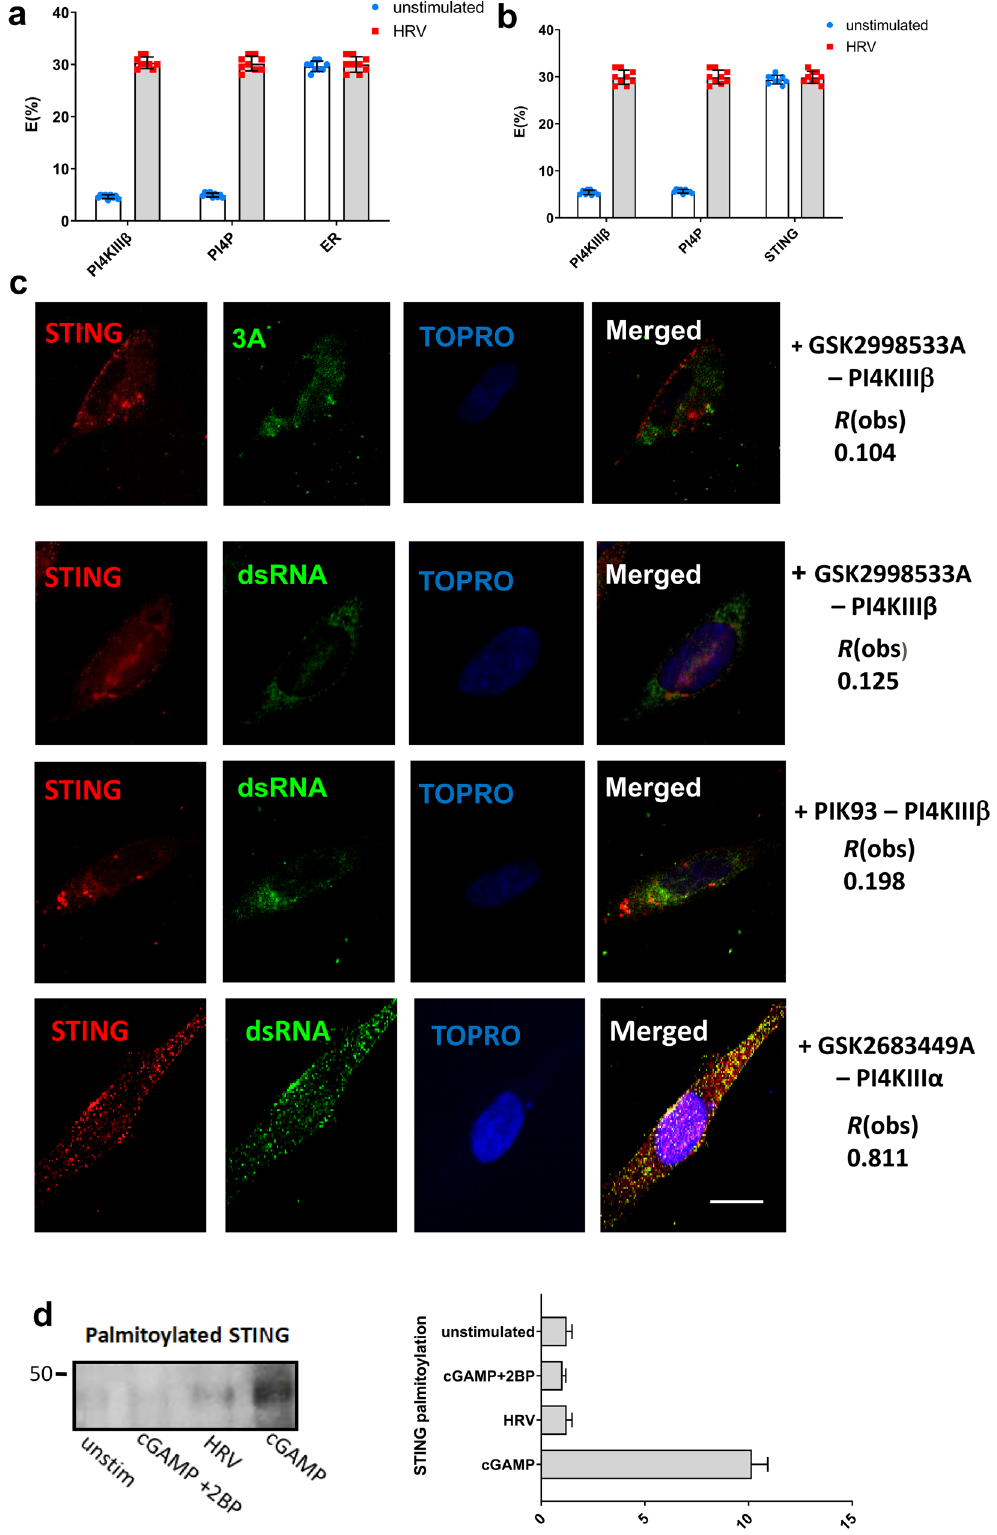
Fig. 4 STING interactions with PI4KIII β , PI4P and ER. Fluorescence resonance energy transfer (FRET) studies to determine STING interactions with PI4KIII β , PI4P and ER ( a ), as well as ER interactions with PI4KIII β , PI4P and STING ( b ) in BEAS-2B cells infected with HRV for 1 h. Data is means + / − SD ( n = 3, independent experiments). BEAS-2B cells infected with HRV-A1B (MOI 10) in the presence of GSK2998533 (100 nM), GSK2683449 (100 nM) or PIK93 (1 µ M) and co-localization of STING, 3A and dsRNA was assessed ( c ). BEAS-2B cells untreated or treated with cGAMP (5 µ g/ml) or infected with HRV (for 4 h) were subjected to Acyl-Biotin Exchange assay (ABE) assay, western blot analysis for STING palmitoylation. Cells treated with palmitoylation inhibitor 2 bromo palmitate (2BP) at 8 µ m for 6 h is also shown ( d ). All data in A-H is shown as a representative image of three biological replicates that included at least 20 technical replicates. Data in G is mean + / − SD ( n = 3, independent experiments). NATURE COMMUNICATIONS| (2022) 13:1406